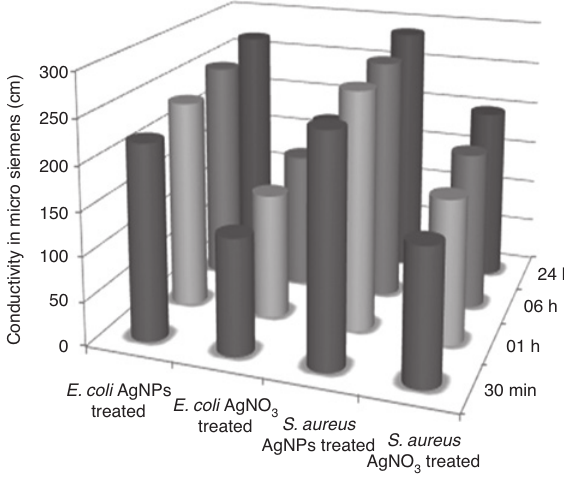
Figure 7: Membrane permeability study of E. coli and S. aureus